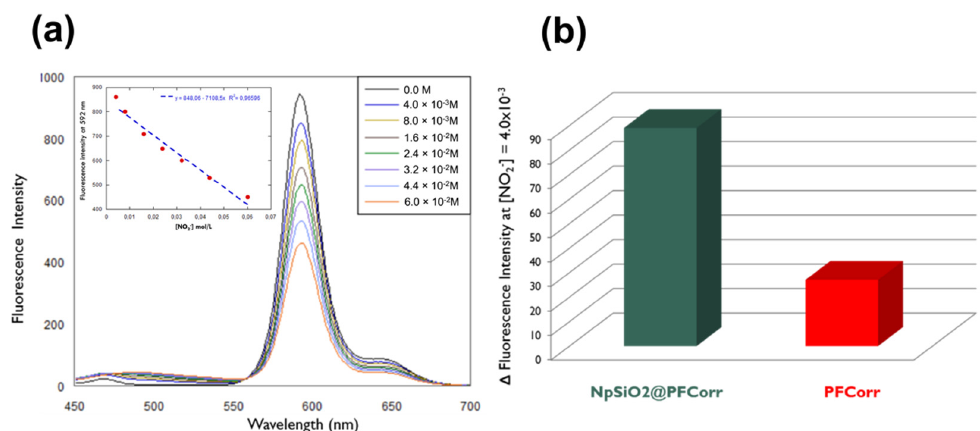
Figure 7. ( a ) Fluorescence response of SiO 2 NPs@ PFCorr toward increasing concentration of nitrites in aqueous solution. In the insert: linear regression curve of SiO 2 NPs@ PFCorr fluorescence intensity quenching at 592 nm vs. [NO 2 − ], mol/L; ( b ) comparison of absolute fluorescence intensity quenching value of PFCorr ligand solution and SiO 2 NPs@ PFCorr suspension in the presence of nitrite in concentration [NO 2 − ] = 4 × 10 − 3 M.